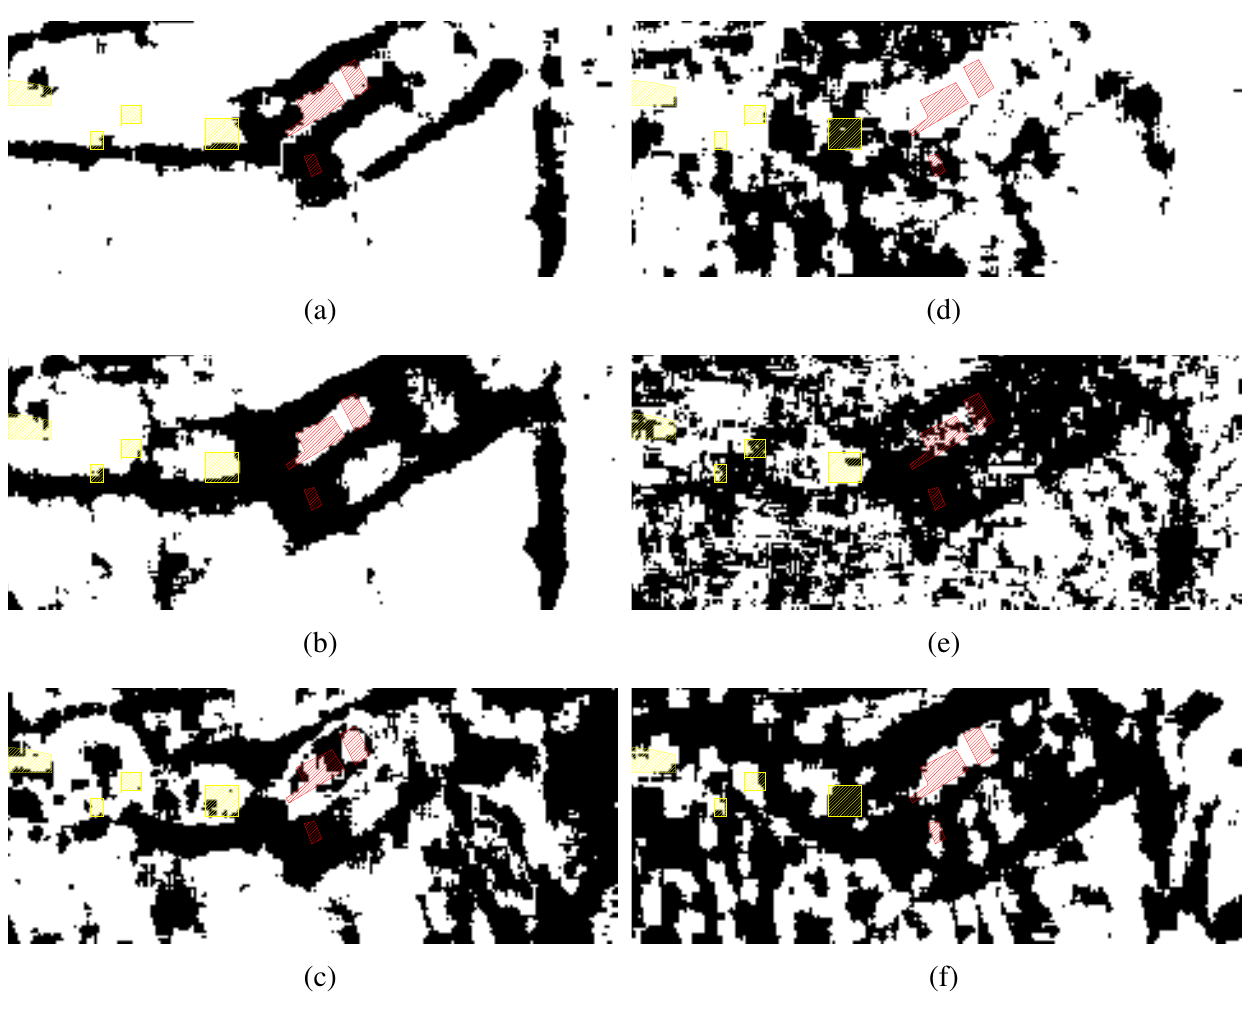
Figure 9. Panchromatic/SAR pair, change/no-change maps based on manually selected sim- ilarity measure thresholds: (a) distance to independence; (b) mutual information; (c) CRA; (d) Woods criterion; (e) robust Woods criterion; (f) correlation ratio. In yellow and red, respectively, the ground truth areas corresponding to new and always present man-made ar-